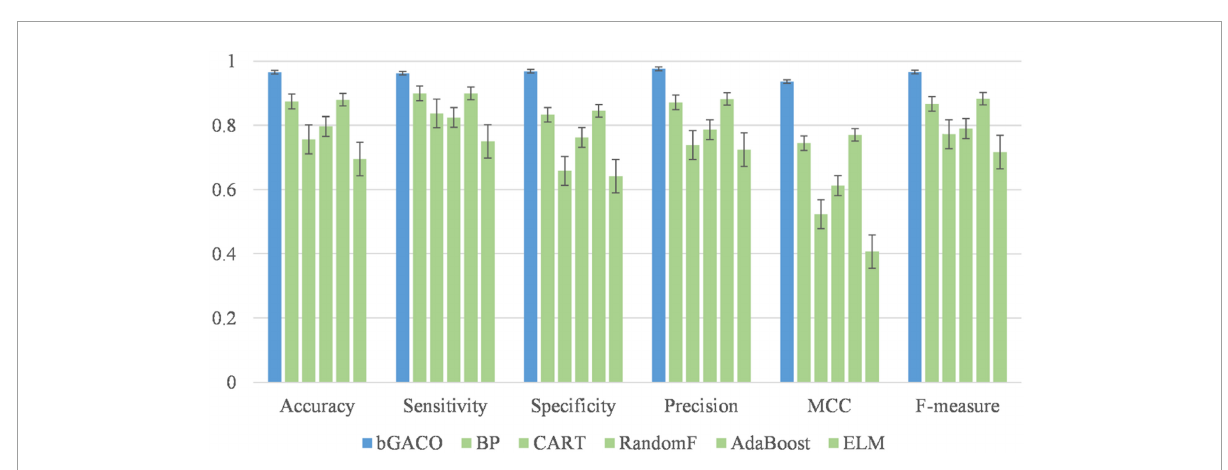
FIGURE8 Comparison of bGACO-SVM with well-known